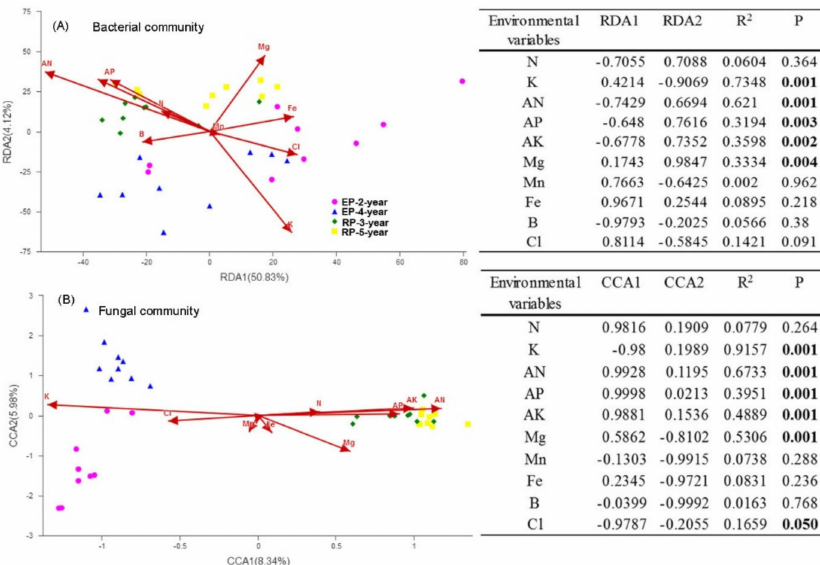
Figure 4. Constrained ordination analysis of microbial communities in 2-year-old and 4-year-old Eucalypt plantations (EP-2-year and EP-4-year) and 3-year-old and 5-year-old Rubber plantations (RP-3-year and RP-5-year). ( A ) Redundancy analysis (RDA) of bacterial community composition and environmental attributes. ( B ) Canonical correspondence analysis (CCA) of fungal community composition and environmental attributes. The relationships between soil variables and the two axes were indicated in the insert tables. Soil total nitrogen (N), total potassium (K), available nitrogen (AN), available phosphorus (AP), available potassium (AK), magnesium (Mg), manganese (Mn), iron (Fe), boron (B), and chlorine (Cl) were selected in the RDA and CCA model after excluding the variables with high variance inflation factor ( > 10).